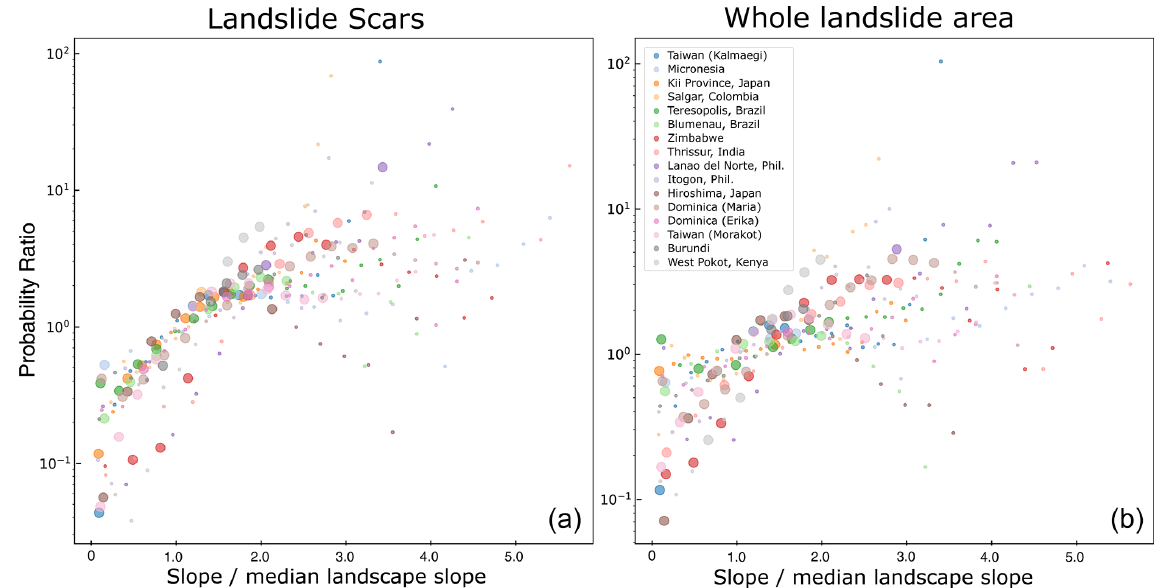
Figure 4. Landslide probability ratio against the slope normalized by the median of the local landscape, for the scar area (a) and the whole landslide area (b) . The size of the points depends on whether the difference between the landslide and topography exceeds the calculated confidence interval for that bin interval; larger points indicate significant deviation ( p > 0 . 95), and small points indicate the difference is not significant at that probability level.